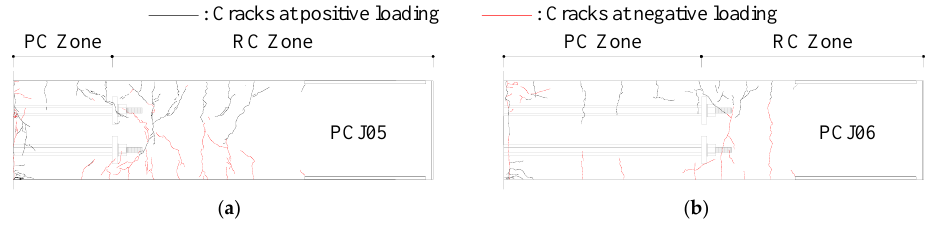
Figure 12. Crack maps: ( a ) PCJ05; ( b ) PCJ06.